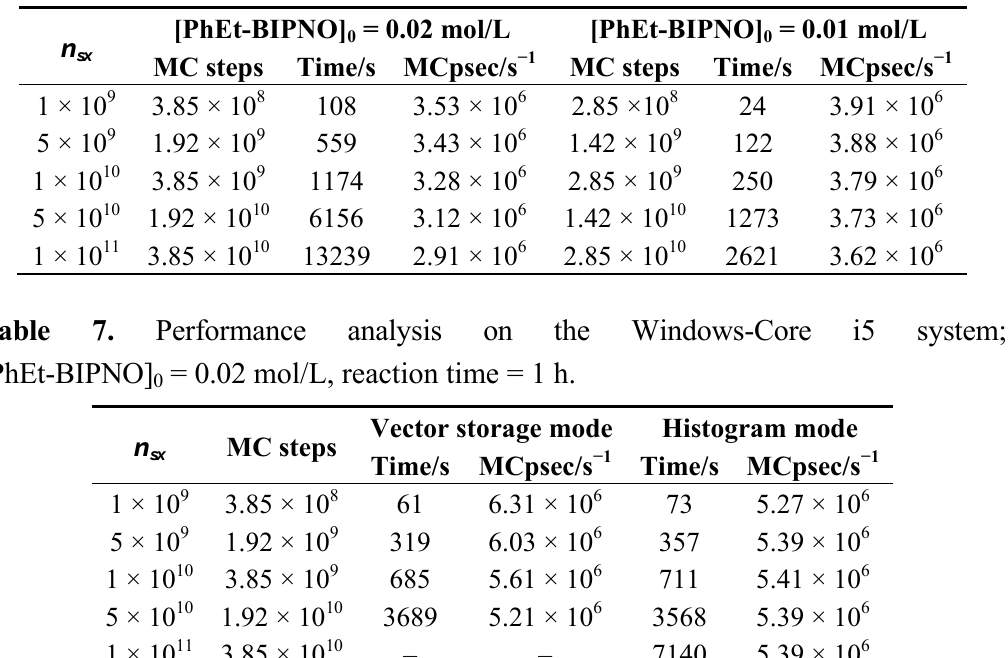
Table 6. Performance analysis on the Linux-Opteron system, reaction time = 1 h.